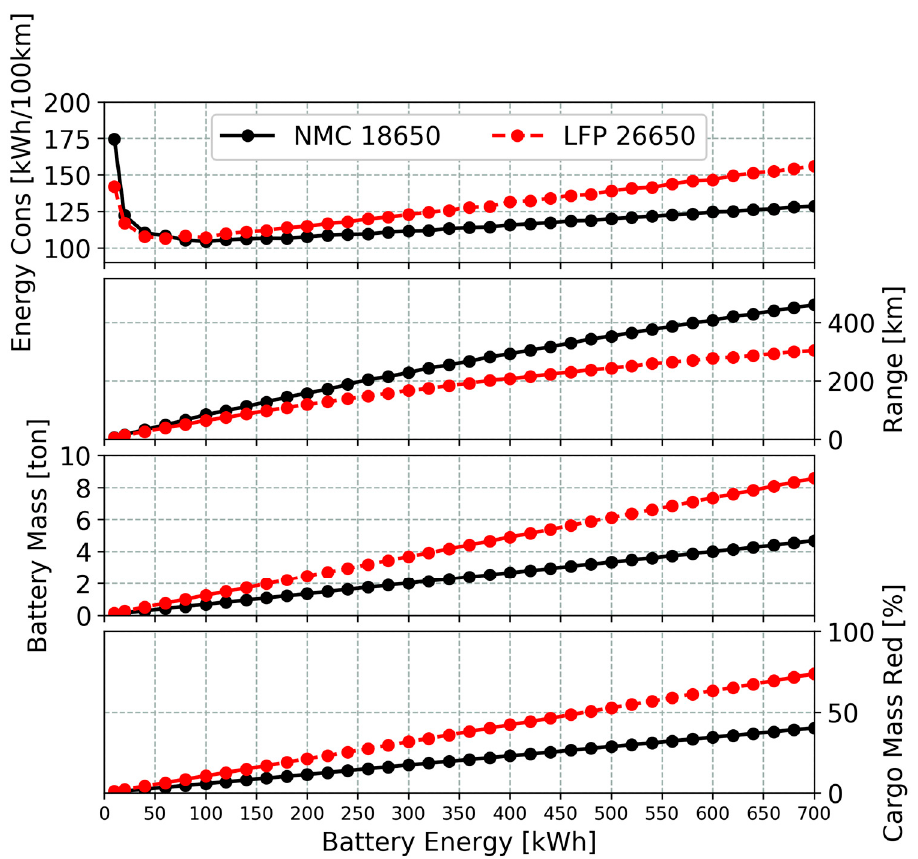
Figure 6. BEV Volvo FL truck performance through the numerical simulation of different battery sizes (energy package content). The energy consumption, vehicle range, battery mass, and cargo mass reduction percentage are presented.